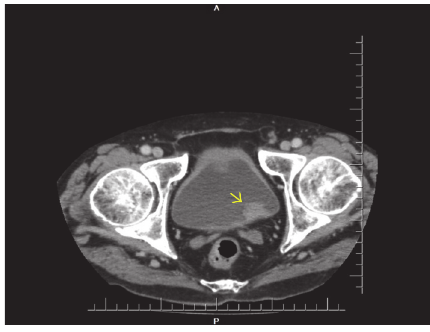
Figure2:AbdomenCT-scandisplayingavegetationonthepostero- lateral bladder wall (arrow).